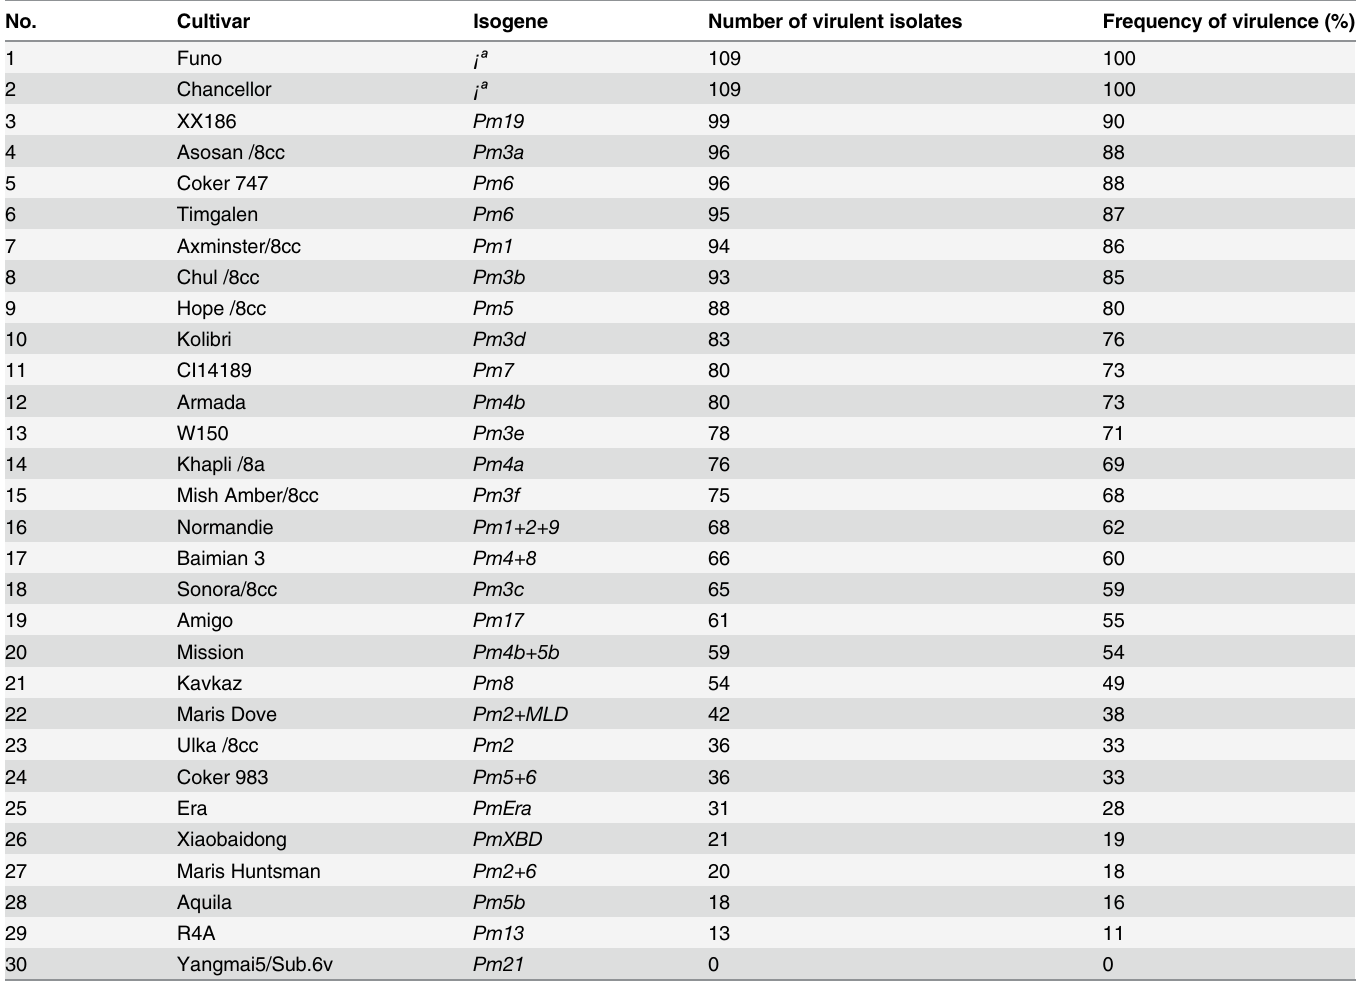
Table 1. Frequency of virulence of Blumeria graminis f. sp. tritici in Sichuan,